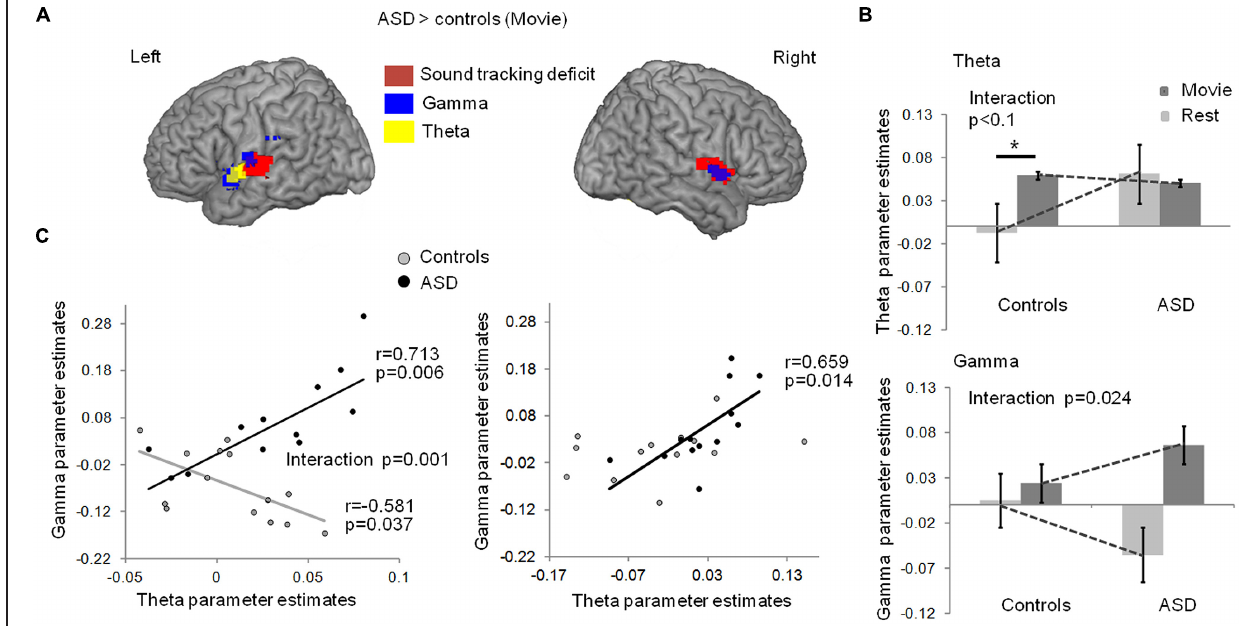
sampled from the left auditory cortex, at the location where there was a significant theta EEG-BOLD effect during the movie in controls (up panel), and a significant decrease in gamma-BOLD coupling at rest in the ASD group (bottom panel). (C) Left panel: in controls, gamma- and theta-BOLD coupling in left auditory cortex were negatively related, in line with a control of gamma by theta activity. In autism, an inverted relation suggests atypical theta/gamma interaction. The group interaction was significant at p = 0.001; Right panel: in the right temporal lobe, the anomaly in autism was less pronounced and the negative correlation between theta and gamma was not present in controls ( p = 0.243). * indicates a significant difference with p <